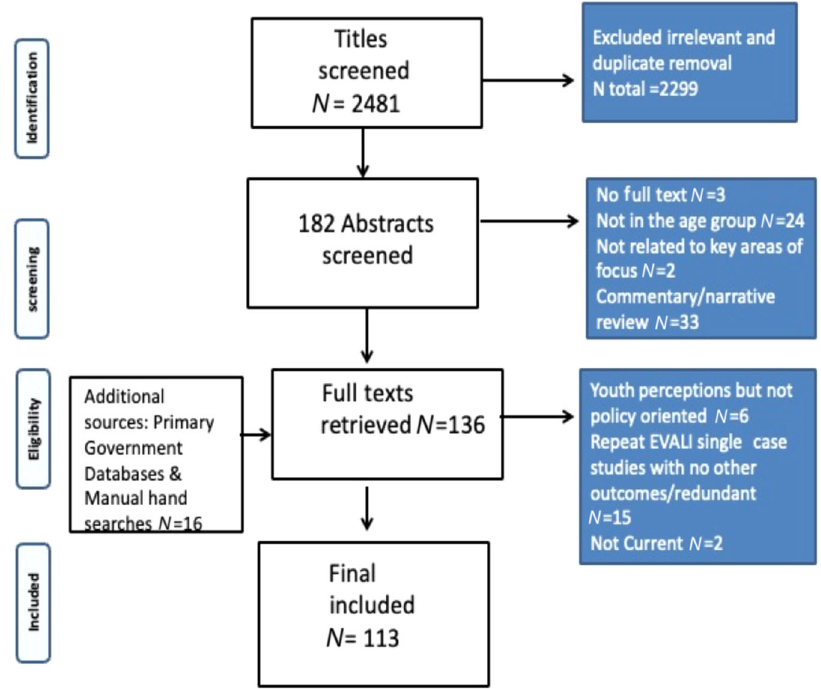
Fig. 1 Prisma fl ow chart.